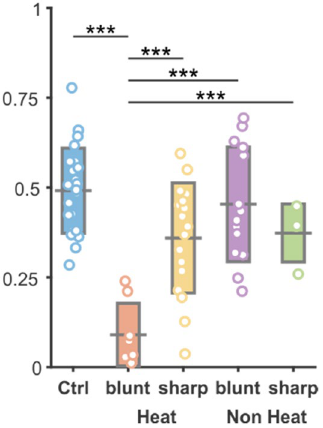
Figure 5. Cell number changes in each experimental group. The mean number of cell counts in each group. Black bar represents mean value, rectangles show standard deviation of mean, while open circles are individual cell count data. Horizontal black lines and stars show the level of significance in a comparison of a given pair of datasets. ***Symbol represents p <